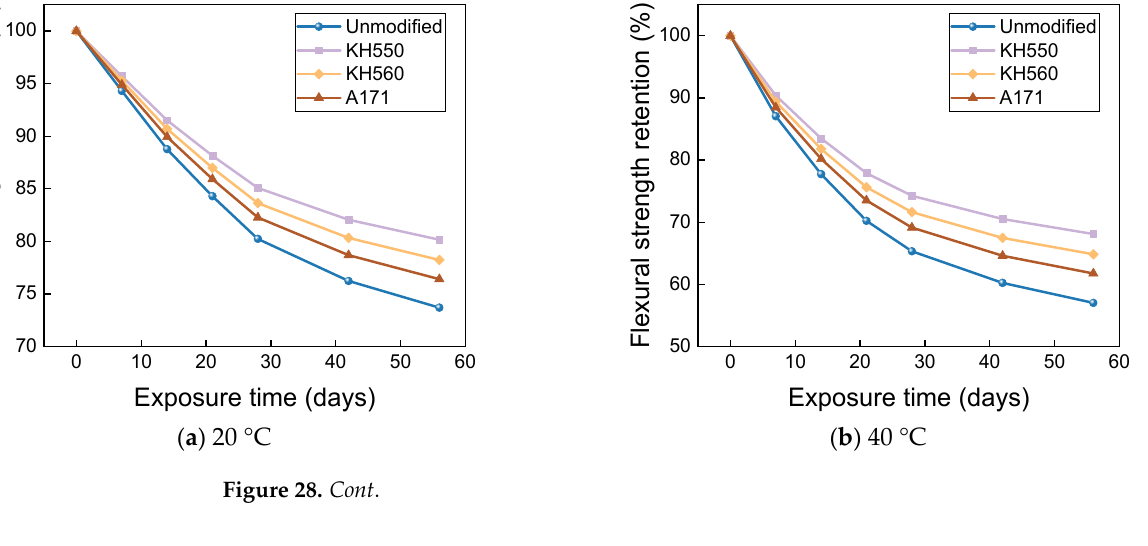
( c ) 60 °C Figure 28. Flexural strength retention in a 10%NaOH alkaline environment. Hydrolysis of resin under alkaline environments. ROOR ∗ + NaOH ⟶ RCOONa + R ∗ OH (2) Reaction of Si-O-Si structure with alkaline environments. Si − O − Si + OH (cid:2879) ⟶ SiOH + SiO (cid:2879) (3) 4. Conclusions In this paper, the changes in the flexural properties of different types of silane coupling agent KH550-, KH560-, and A171-modified basalt-fiber-reinforced composites immersed in water at 20 °C, 40 °C, and 60 °C and 3.5% NaCl seawater, 10% NaCl high- concentration seawater, 10% H 2 SO 4 acidic, and 10% NaOH alkaline environments were studied, and the following conclusions were drawn: (a) The modification by silane coupling agents KH550, KH560, and A171 improved the interfacial bonding effect of BFRPs. Without the modification by silane coupling agents, there were large gaps between the fibers and the matrix, and the interfacial bonding effect was poor. (b) The appearance of BFRPs varied greatly in different soaking environments. The samples soaked in water, 3.5% NaCl seawater, and 10% NaCl seawater environments did not show large changes, while the appearances of the samples soaked in acidic and alkaline environments showed great changes. Meanwhile, the appearance of BFRPs was greatly affected by the ambient temperature and soaking time, and a large